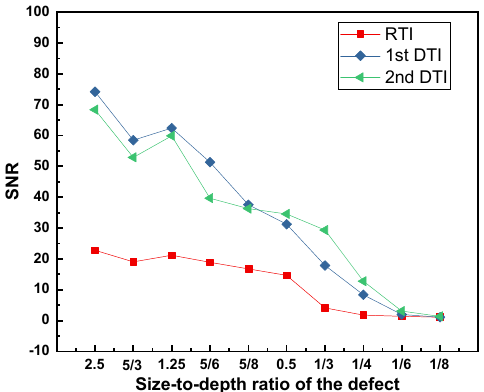
Figure 7. The SNR for each size-to-depth ratio of the defect.